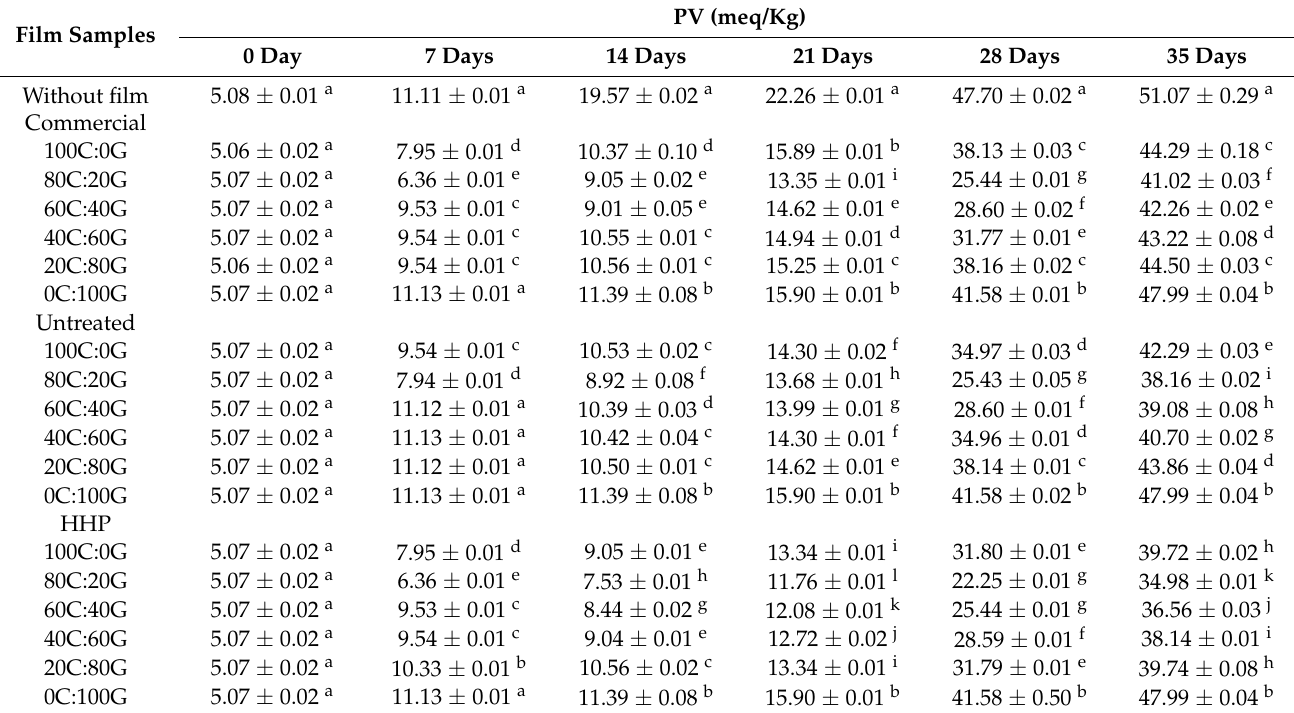
Table 4. PV value of composite